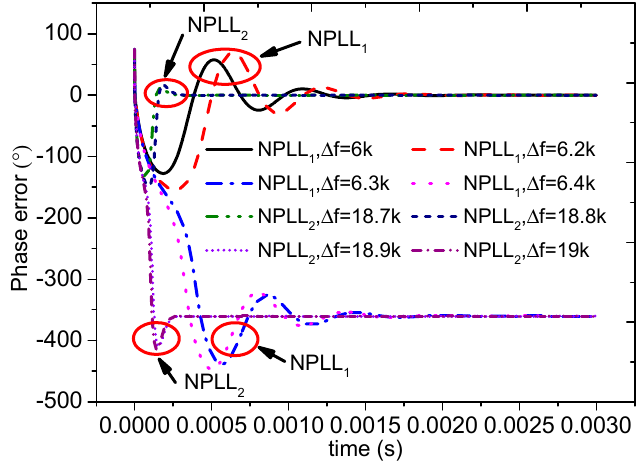
Figure 11. Phase error of PLL under different frequency offsets.